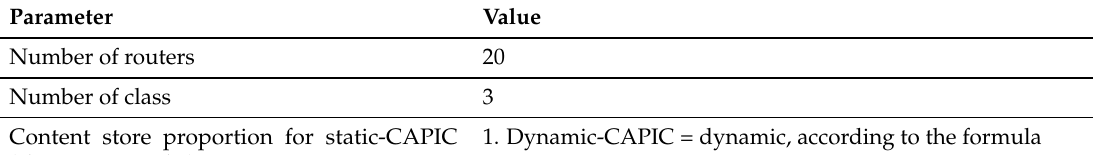
Table 2. Simulation